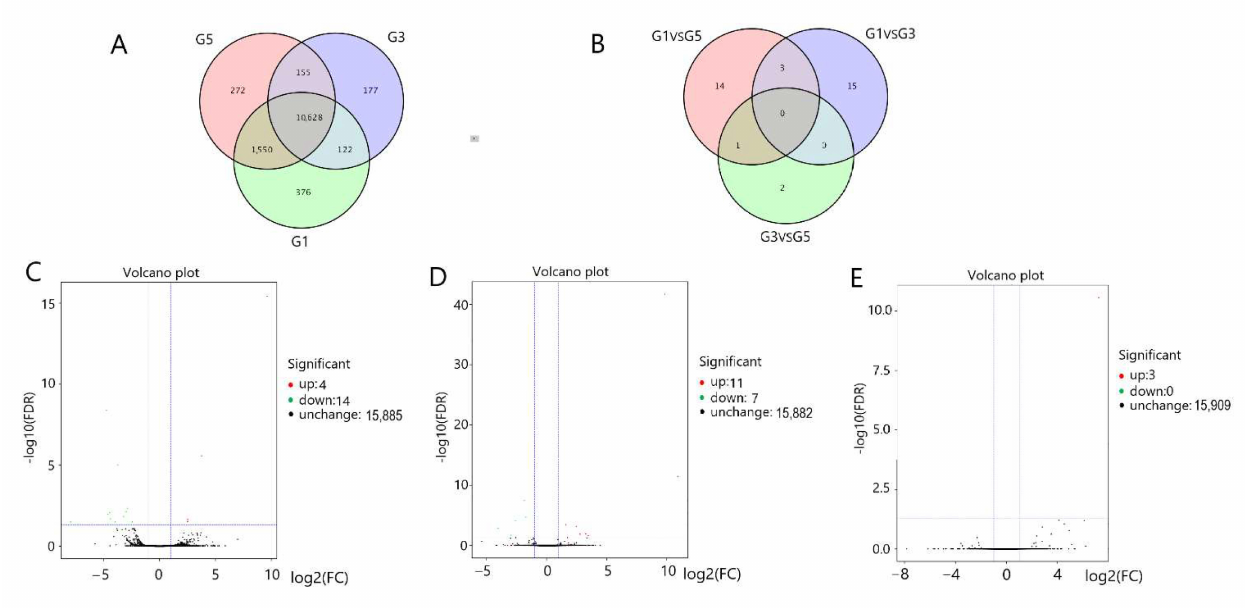
Figure 1. Gene expression patterns in the pituitary glands: ( A ) Gene set at different developmental stages in the pituitary tissue; ( B ) DEGs expressed in the pituitary gland. DEGs expressed in a volcano plot in: ( C ) G3 vs. G1; ( D ) G5 vs. G1; ( E ) G5 vs. G3. G1, G3, G5 = 6-month-old, 18-month-old, 30-month-old Angus cattle pituitary,